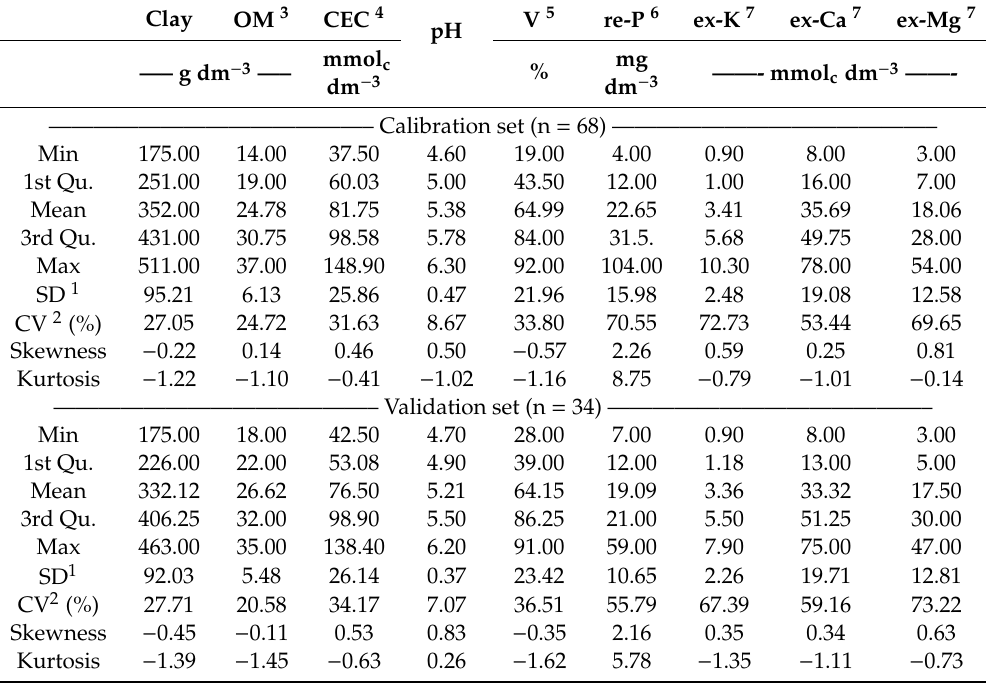
Table 1. Descriptive statistics of fertility attributes for the calibration and validation